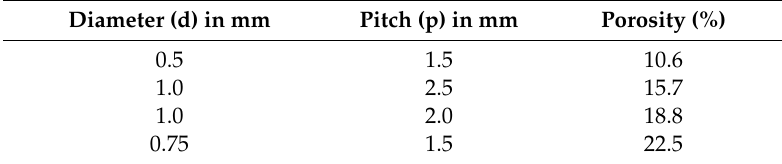
Table 2. Percentage variation of porosity with respect to the diameter and pitch of the